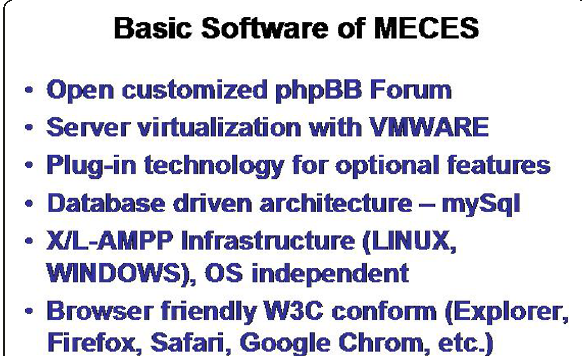
Figure 8 Basic software of MECES .